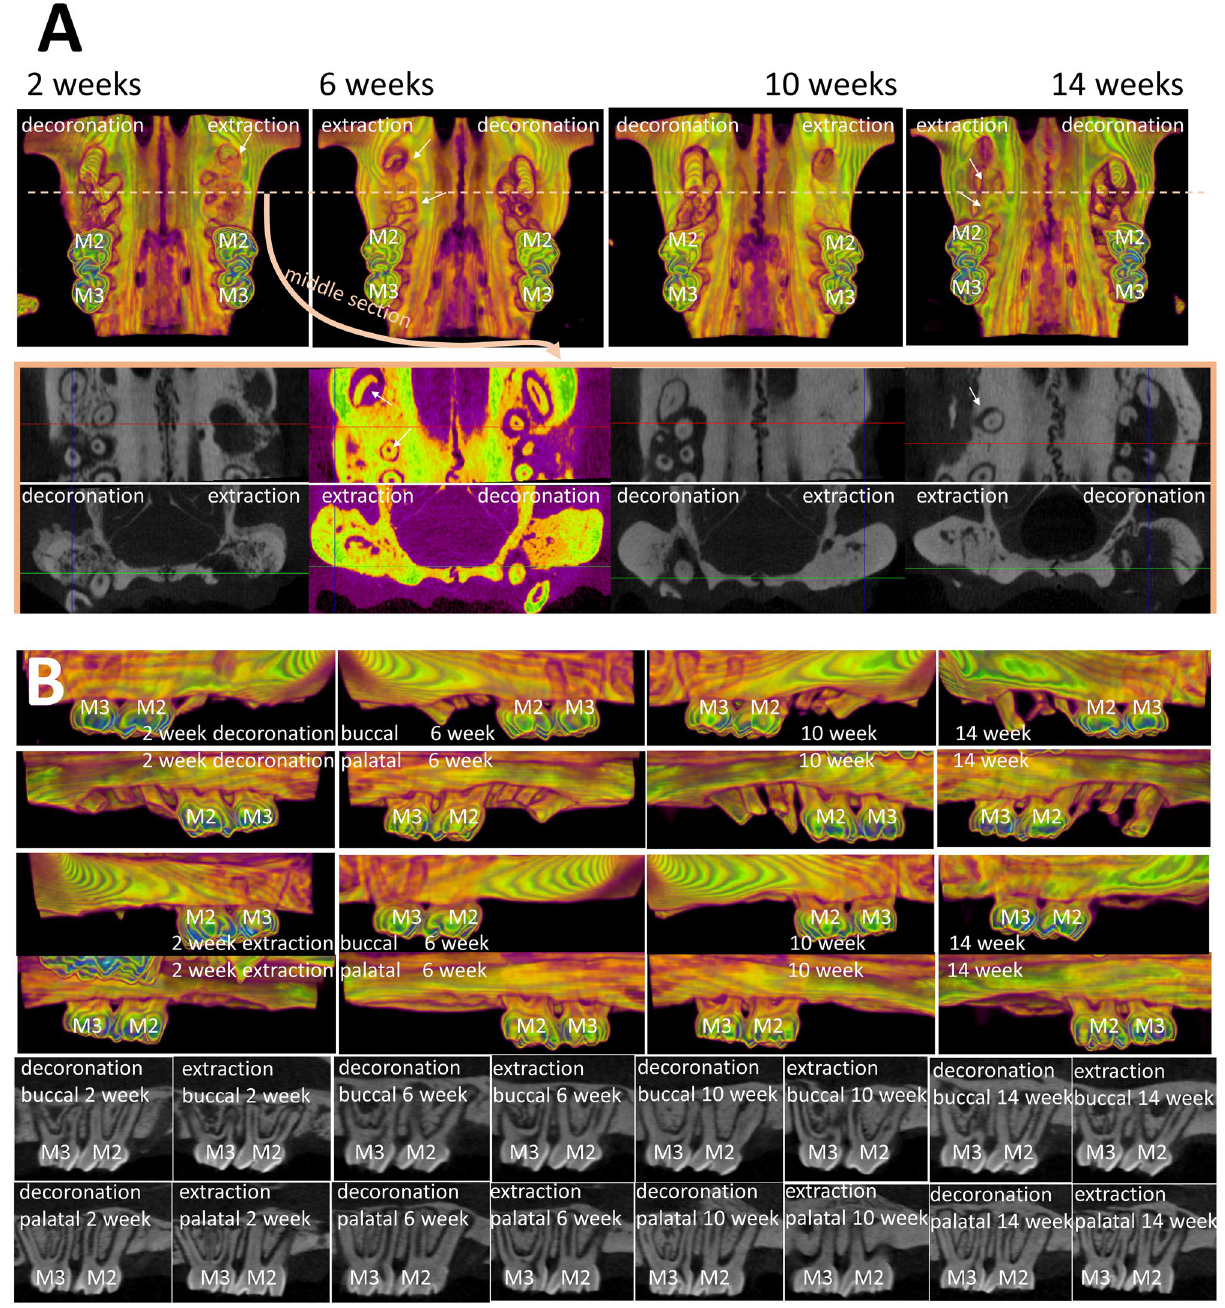
Figure 2. Comparison of the effectiveness of alveolar ridge preservation at maxillary first molar (M1) and the periodontal condition at maxillary second molar (M2) and third molar (M3) after decoronation or extraction of M1. ( A ) Comparison of the effectiveness of alveolar ridge preservation with decoronation technique at maxillary first molar (M1) examined by micro-CT. Representative images show the 3D occlusal view (top), the coronal view, and the transaxial section in the middle of M1 site (bottom) at 2, 6, 10, 14 weeks. Fuller bone contour and better bone height were obvious on the decoronation side compared to the contralateral extraction side. Please note that some root fragments remained in the extraction side (white arrow). ( B ) Comparison of the periodontal condition at maxillary second molar (M2) and third molar (M3) after decoronation or extraction of M1. Representative images show the 3D buccal and palatal views on the decoronation and extraction sides (color images) and 2D sections cut along a profile line through the buccal aspect or palatal aspect of M2 and M3 (black/white images). On the decoronation side, significant more bone resorption may be seen at both buccal and palatal aspects of the M2 teeth, especially at mesial